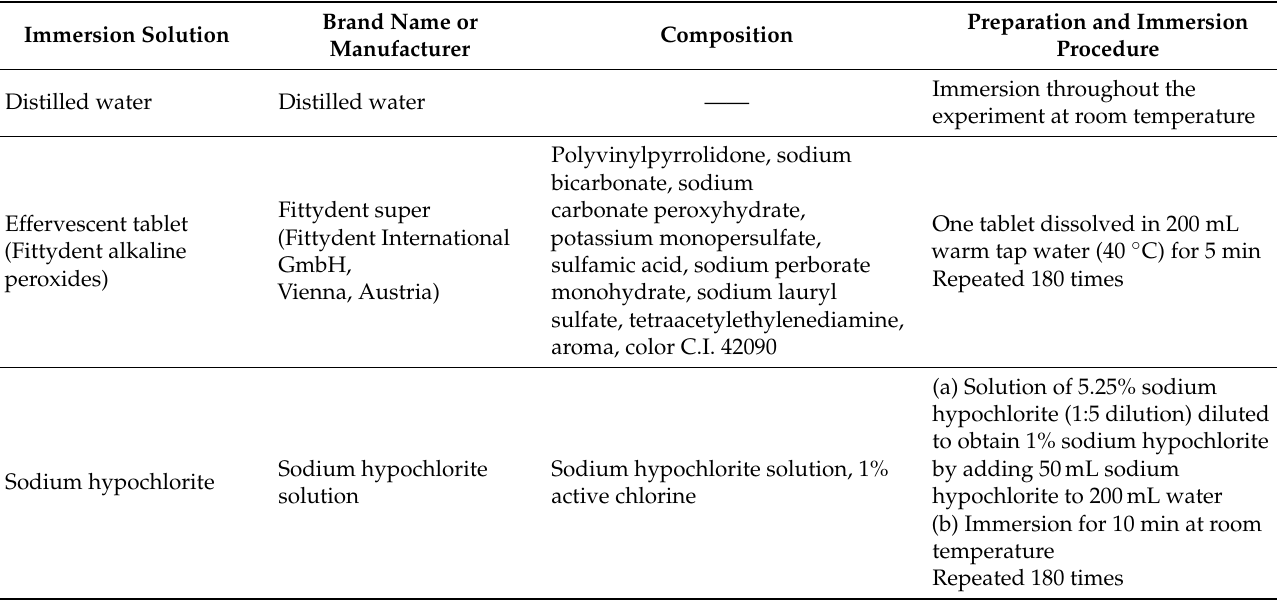
Table 2. Immersion solution preparation and immersion